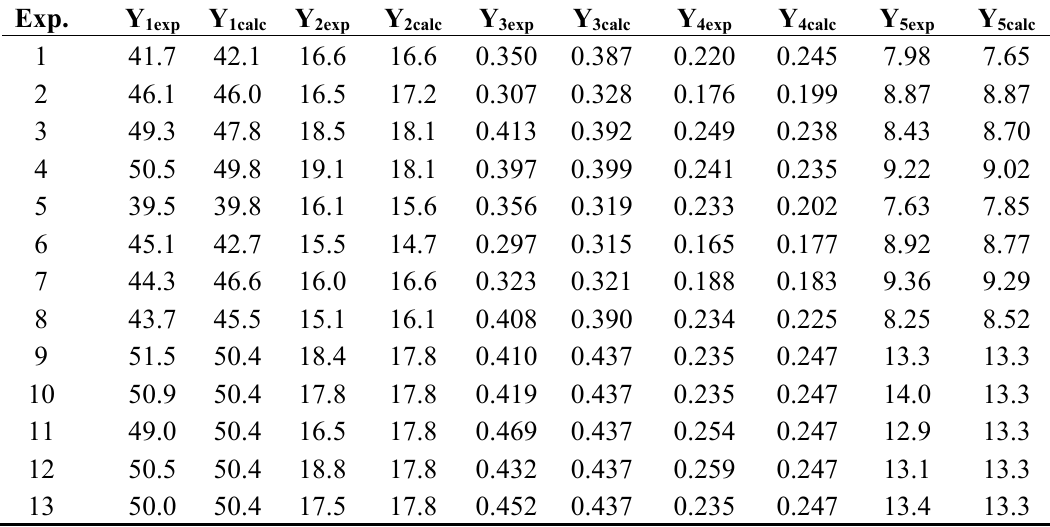
Table 4. Experimental and calculated values of the objective functions during desorption from Amberlite XAD16HP resin.